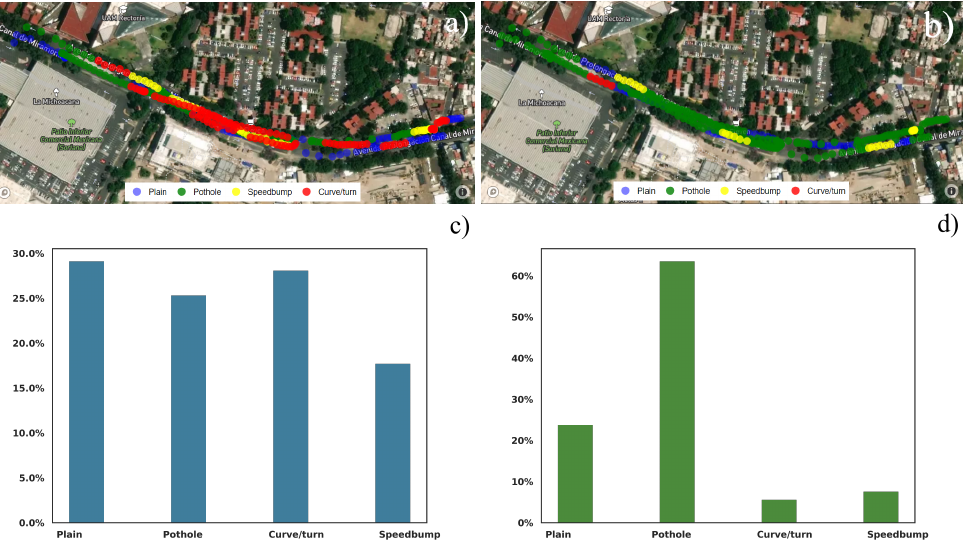
Figure 13. Geo spatial representation of the different anomalies by the KNN algorithm. ( a ) KNN ( b ) ANN. Barchart of the various anomalies classified by the ANN algorithm by percentage ( c ) KNN ( d )